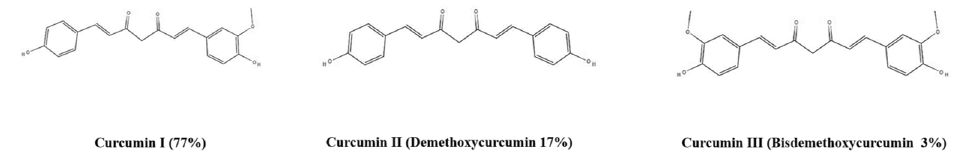
Figure 2. Phytoconstituents of Curcuma longa . Curcumin I (77%), curcumin II (demethoxycurcumin 17%), and curcumin III (bisdemethoxycurcumin 3%) constitute the curcuminoids isolated from turmeric.